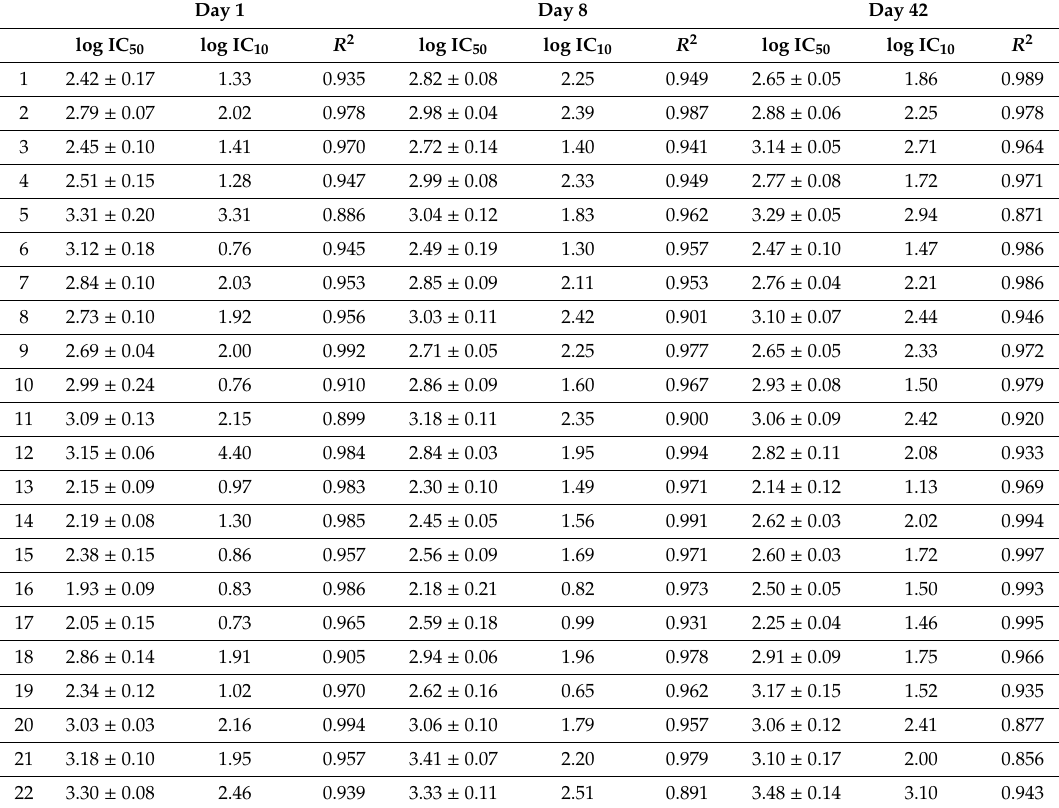
Table 1. Oxytetracycline toxicity on soil bacterial community growth estimated as log IC 10 and log IC 50 values (mean ± standard error, n = 3) after 1, 8, and 42 incubation days. R 2 values represent the coe ffi cients of determination for the logistic